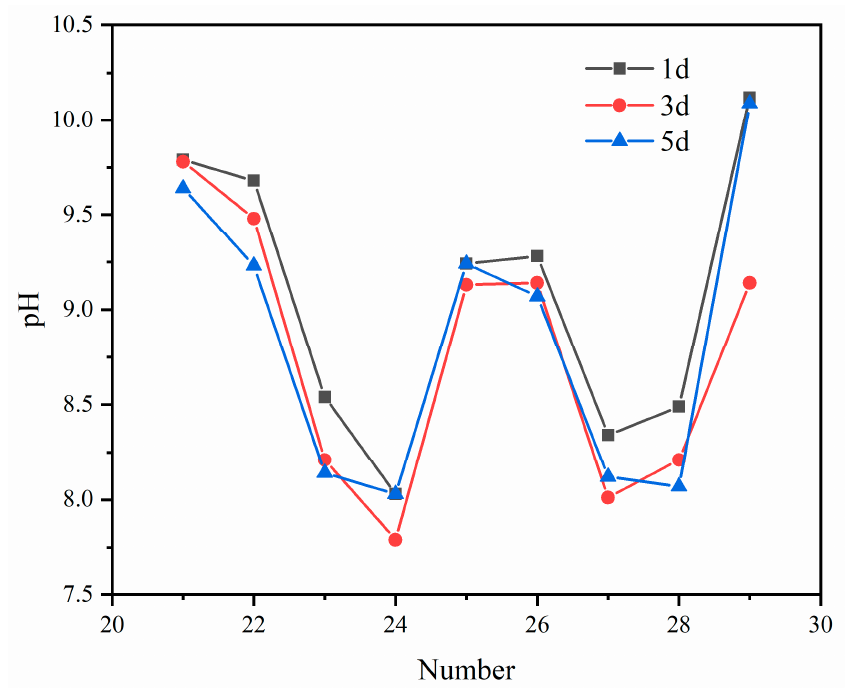
Figure 9. The pH change of different formulas and times.